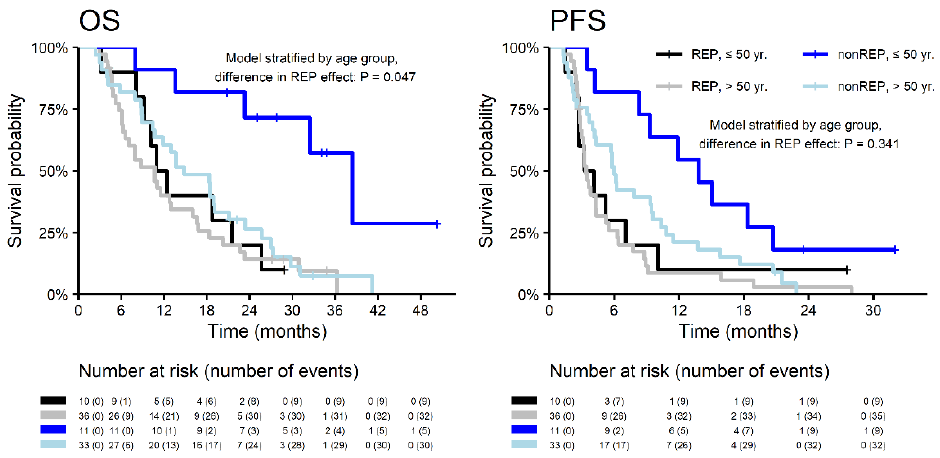
Figure 3. Overall survival and progression-free survival in patients with REP and non-REP in relation to age.